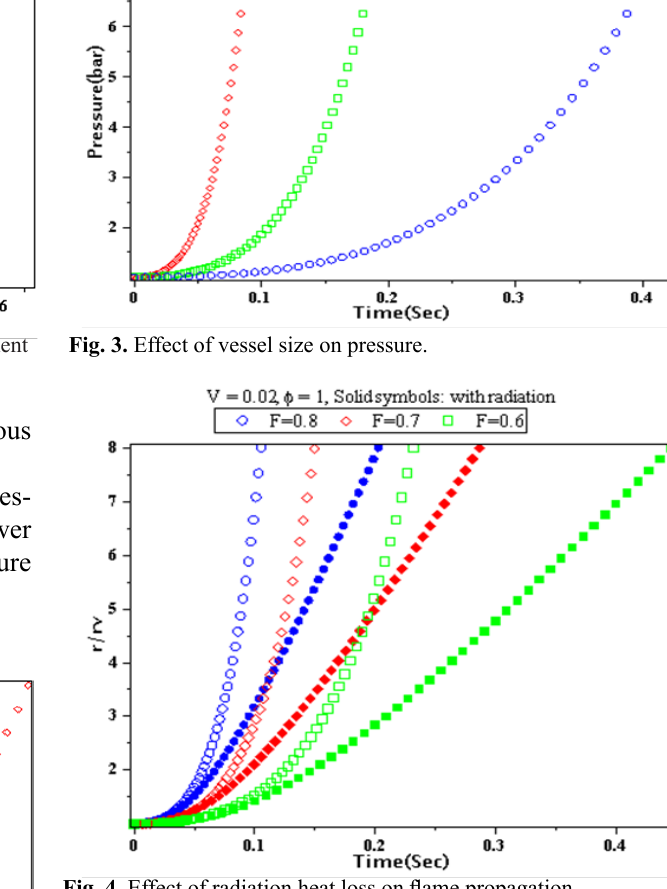
Fig. 4. Effect of radiation heat loss on flame propagation